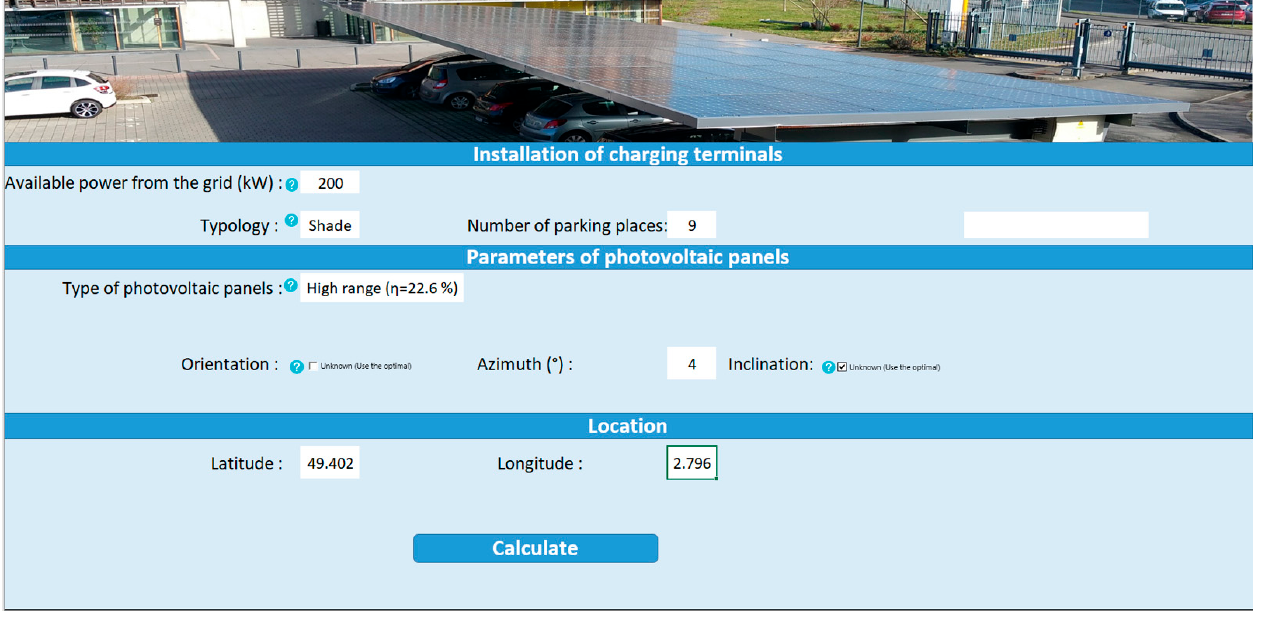
Figure 2. Interface for input data entry (numerical values for the maximum sizing).